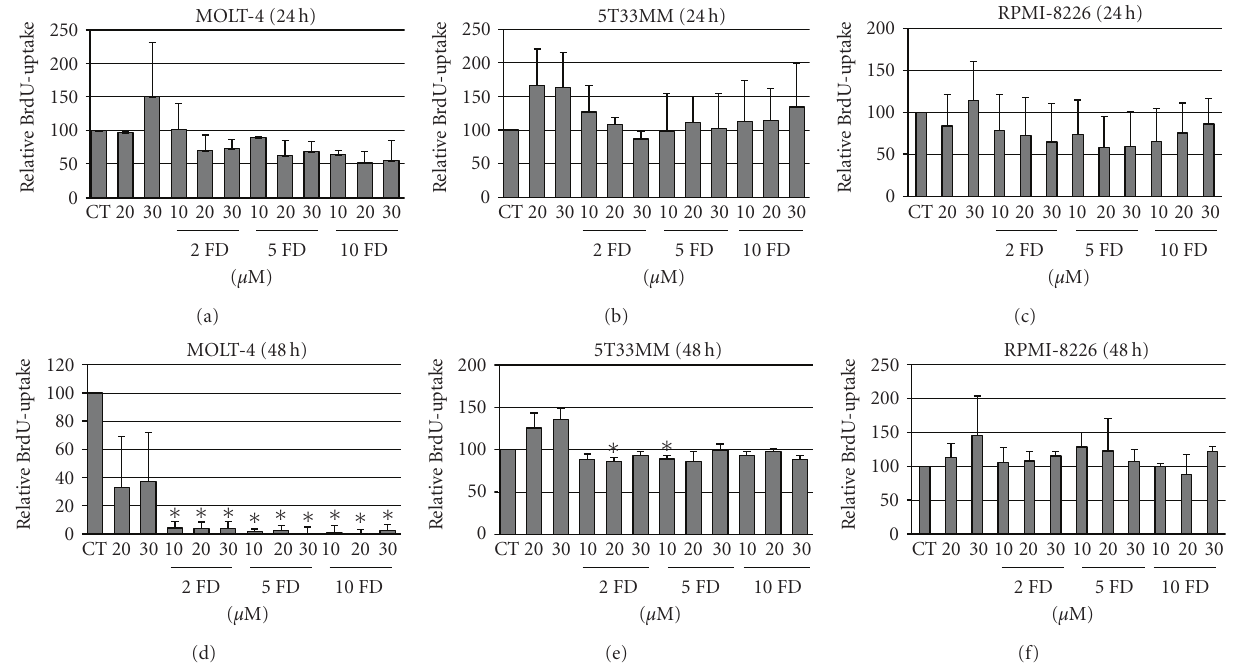
Figure 3: E ff ect of forodesine on proliferation of MM cells. The relative amount of BrdU uptake is shown in MOLT-4, 5T33MM, and RPMI- 8226 cells treated with di ff erent concentrations of forodesine and dGuo at 24 hours (a, b, c) and 48 hours (d, e, f). The mean value + SD is shown of 3 independent experiments; ∗ P < . 05 compared to CT, CT = control, and FD = forodesine.